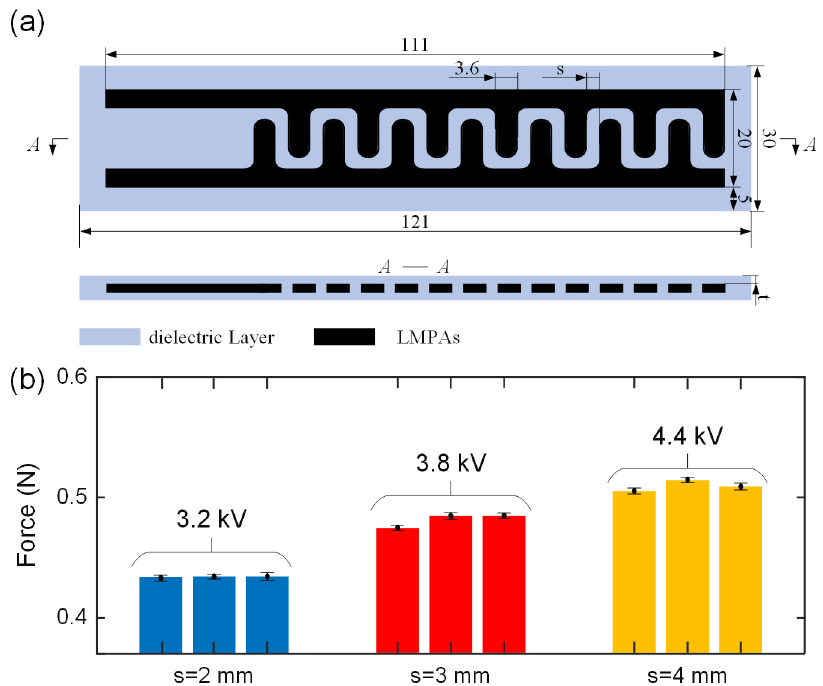
Figure 4. Tangential EA force repeatability test: ( a ) the EA pad design and dimension, and ( b ) mea- sured tangential forces of nine EA pads with three space geometry. Means and one standard deviation for three tests are